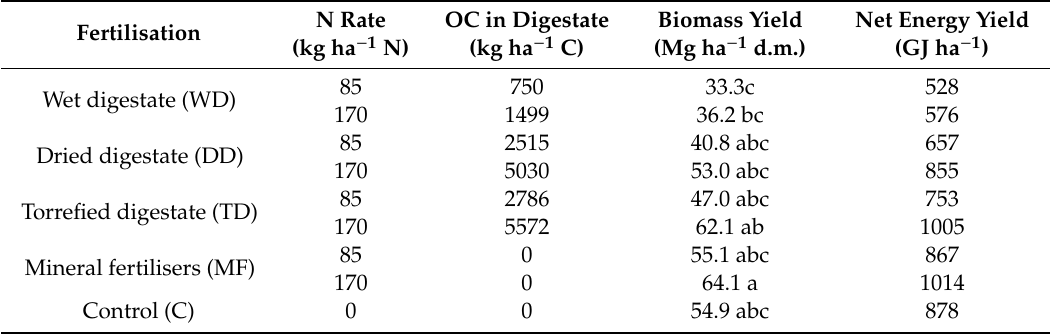
Table 2. Organic carbon (OC) contribution of digestates, dry biomass yield, and net energy yield during 15 years of miscanthus